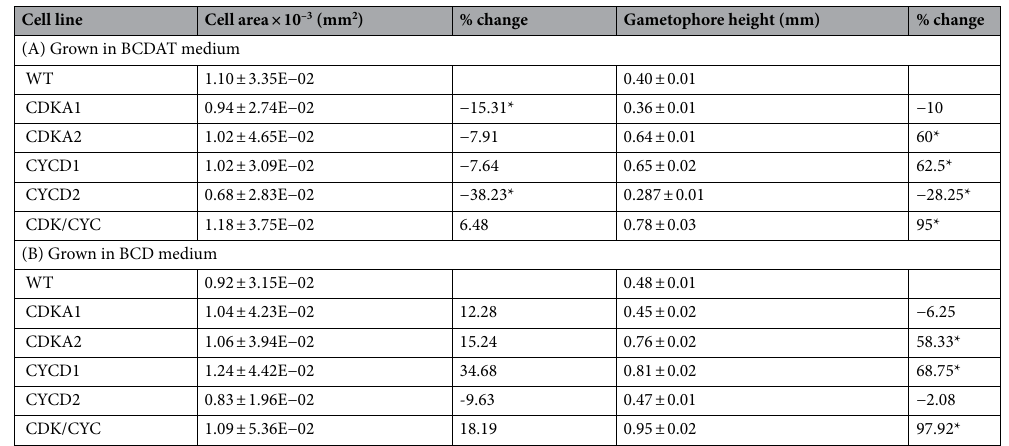
Table 1. Comparison of cell area and gametophore height of WT and transgenic cell lines. The cell lines are ZmUbi:PpCDKA1 (CDKA1) , ZmUbi:PpCDKA2 (CDKA2) , ZmUbi:PpCYCD1 (CYCD1) , ZmUbi:PpCYCD2 (CYCD2) , ZmUbi:PpCDKA1-PpCDKA2-OsAct:PpCYCD2-PpCYCD1 (CDK/CYC) and wildtype (WT). Cell area and gametophore height of cells (n > 50) grown in (A) BCDAT medium, (B) BCD medium for 35 days. % change represents the cell area and gametophore height difference of WT to the transgenic lines. Significance of the data was determined by one-way ANOVA test; P < 0.001 marked with an